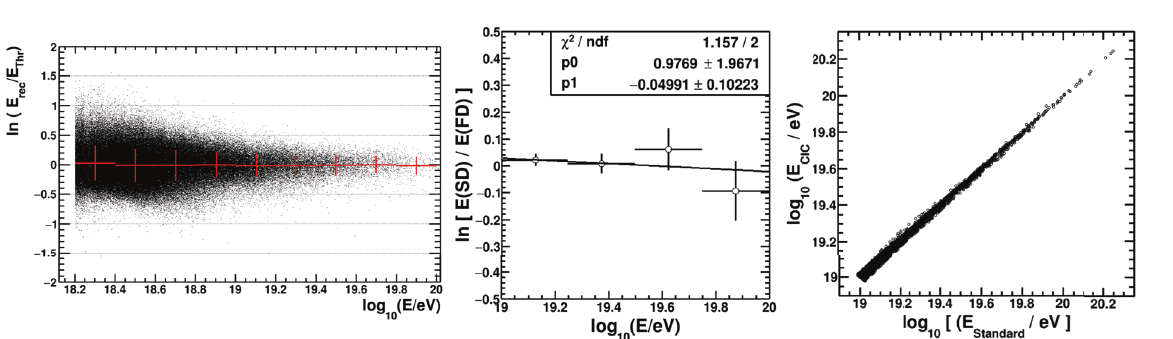
Figure 2. Linearity in energy reconstruction. The ratio between reconstructed energy and thrown energy in Monte Carlo simulation (left), the ratio between reconstructed energy measured by SD and FD (middle), and the comparison of energies determined by the TA’s standard SD reconstruction method and the Constant Intensity Cut method (right) as a function of energy show consistent results of the linearity in the energy reconstruction.